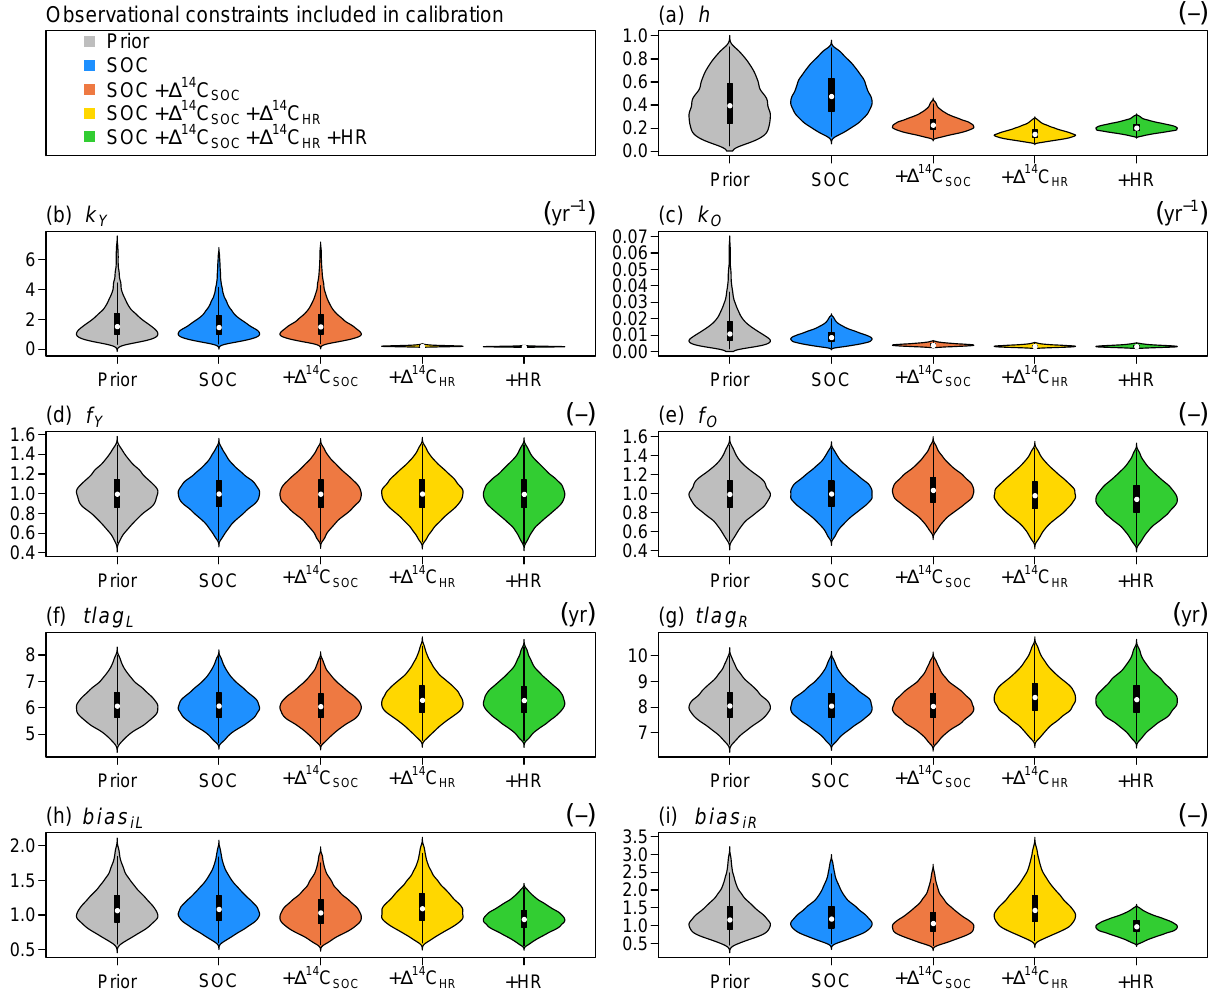
Fig. A2. Solling D0. Violin plots of the posterior distributions of parameters using different combinations of observational constraints (legend). The first column shows the prior distribution of the parameter. The violins show a kernel density estimation of the prior and posterior. The white dots indicate the median of the parameter set, black boxes indicate the interquartile range (IQR) between the 25th and 75th percentile, the thin black lines indicate the upper and lower adjacent